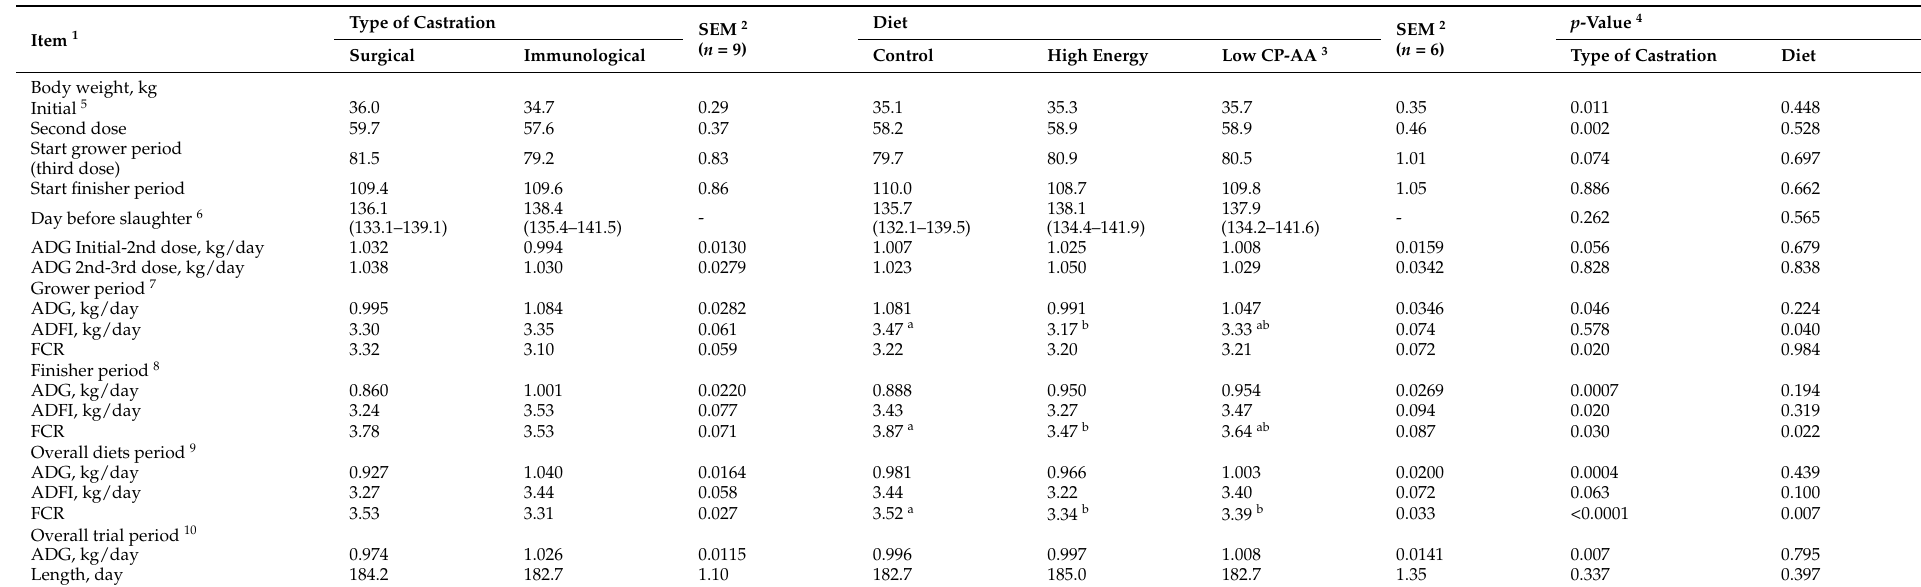
Table 2. Impact of type of castration and diet on growth performance (least square means) of heavy male